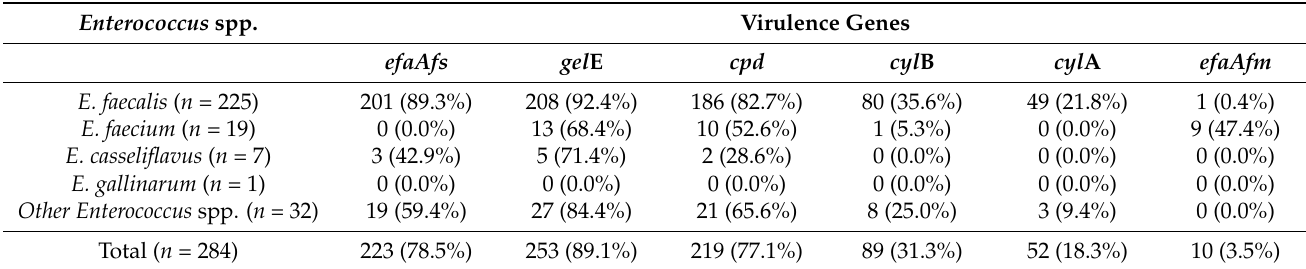
Table 3. Prevalence of virulence genes in all Enterococcus